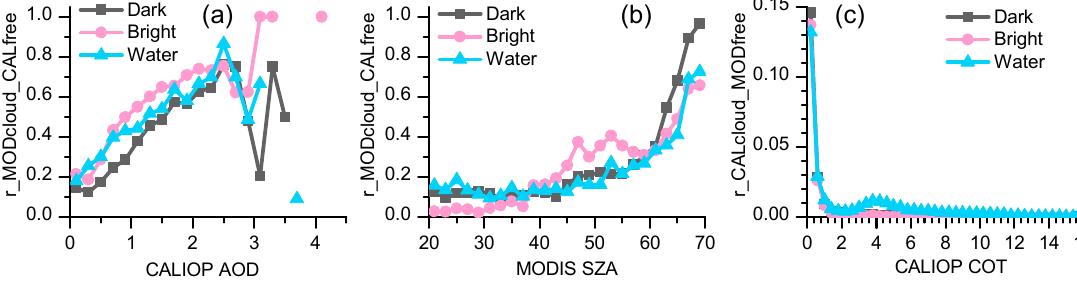
Figure 5. Variations in r_MODcloud_CALfree with ( a ) AOD and ( b ) SZA, and ( c ) variations in r_CALcloud_MODfree with COT.